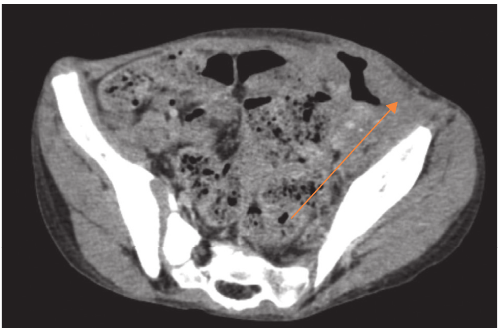
Figure 1: This collection is fistulized against the skin at the RLQ (arrow).